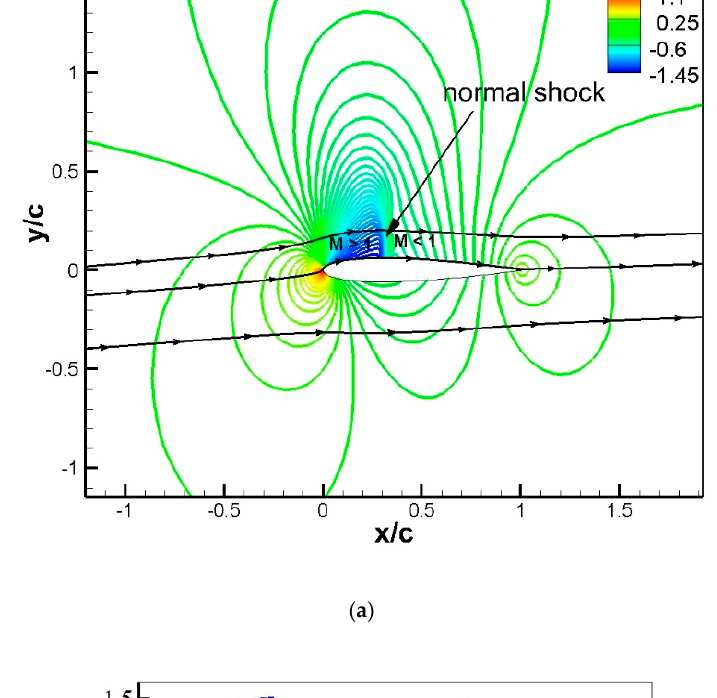
Figure 8. ( a ) Coefficient of pressure contours and ( b ) surface pressure coefficient for the NACA0012 airfoil at Mach = 0.7 and Re (cid:2998) = 9 × 10 6 at an angle of attack = 1.5° compared with the experimental data [23].